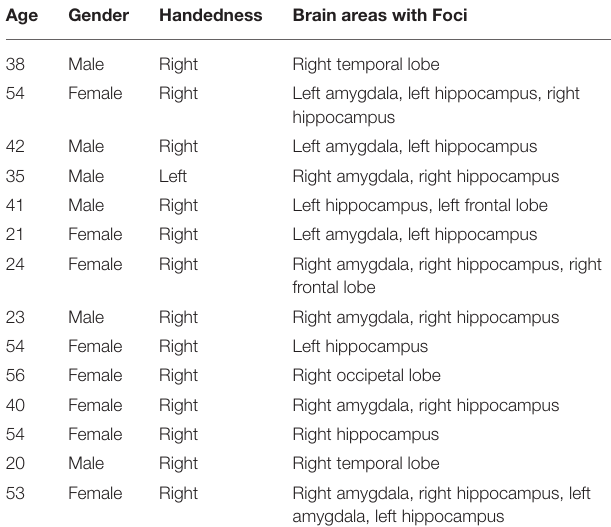
TABLE 1 | Subject characteristics and clinically identified seizure